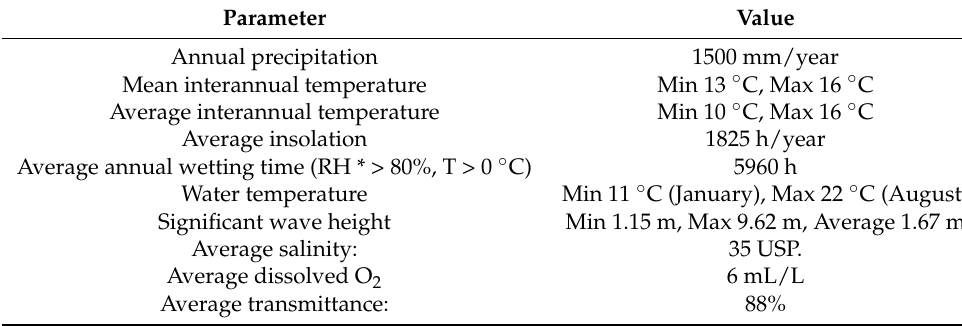
Table 3. Environmental conditions at the HarshLab testing facility.